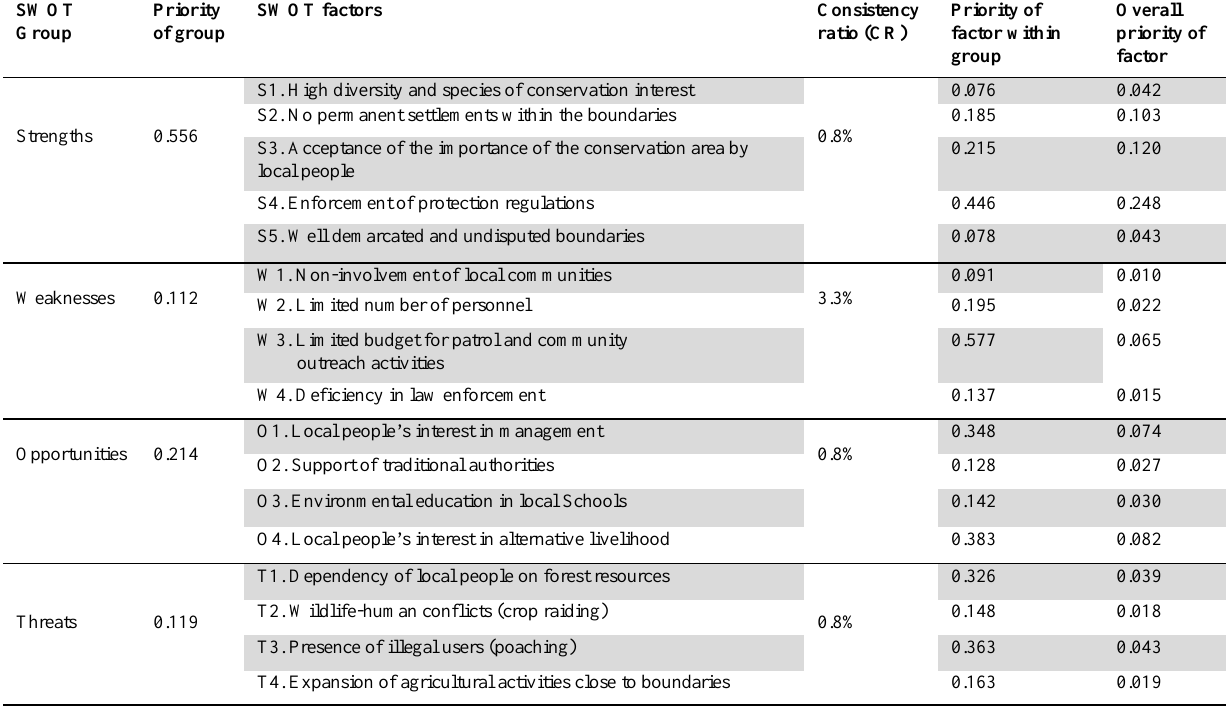
Priorities and consistency ratios of the SWOT groups and